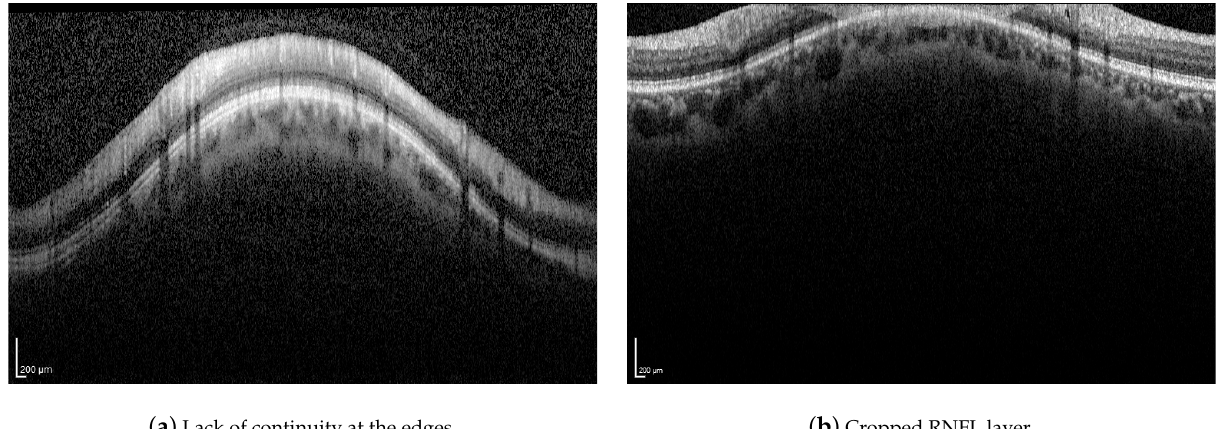
Figure 19. Examples of challenging images for the application of the proposed